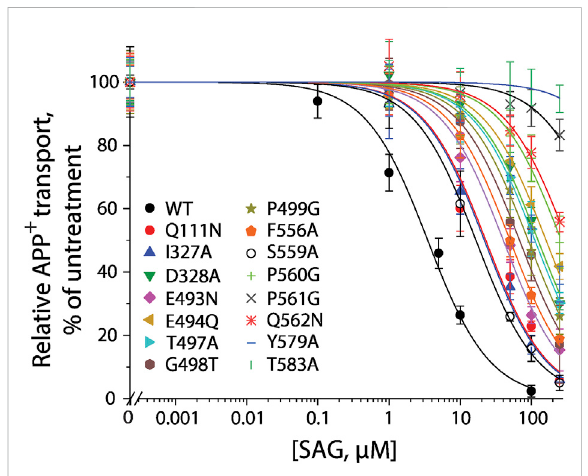
FIGURE 4 SAG inhibition of APP + transport by hSERT and its S2 site mutants. APP + transport into the cells expressing hSERT or its mutants was measured over the indicated range of SAG concentrations as described under “ Materials and methods ” . Nonspeci fi c APP + transport was measured in the presence of 10 μ M fl uoxetine and subtracted to give the values of APP + transport. Graph shows representative experiments for SAG inhibition of hSERT and its mutants, with APP + transport expressed as a percentage of that measured in the absence of SAG. All error bars represent SDs from at least ten measurements. Experiments were repeated twice more with similar results.